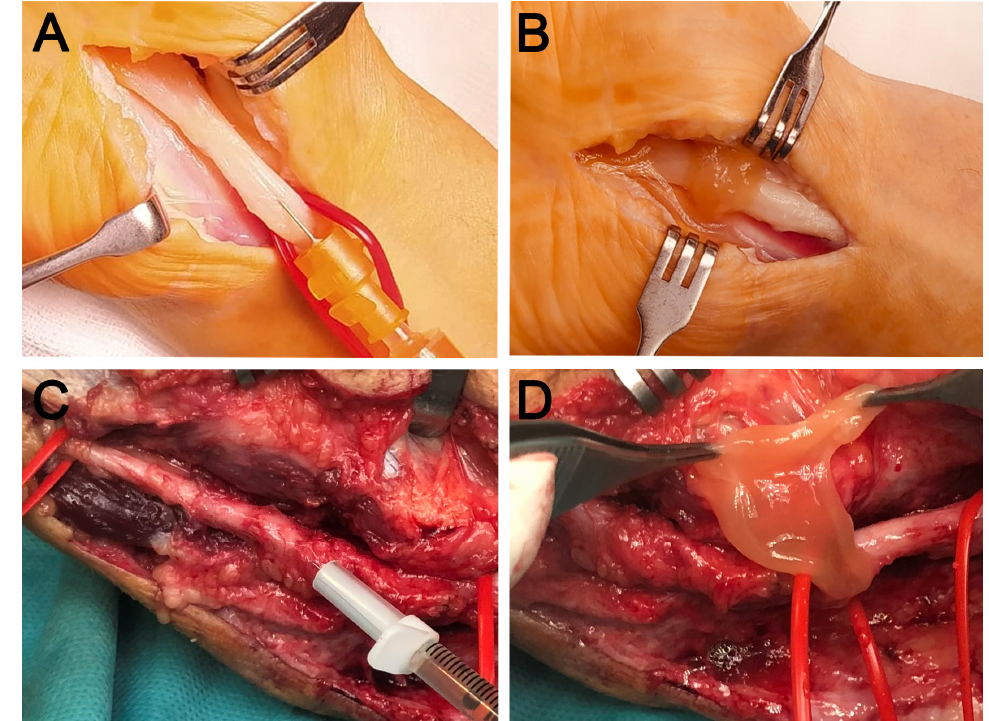
Figure 1. Representative images of two cases of nerve compression in the upper limb. Open surgical release of the carpal retinaculum ( A , B ) and of the ulnar epitrochlear ligament ( C , D ). In the case of the median nerve, intraneural PRGF ( A ) is applied after release and subsequently wrapped with a PRGF membrane ( B ). Similarly, in the case of the ulnar nerve, intraneural infiltration is performed after neurolysis ( C ), followed by the application of a PRGF fibrin membrane ( D ) in order to avoid postoperative fibrotic entrapment.